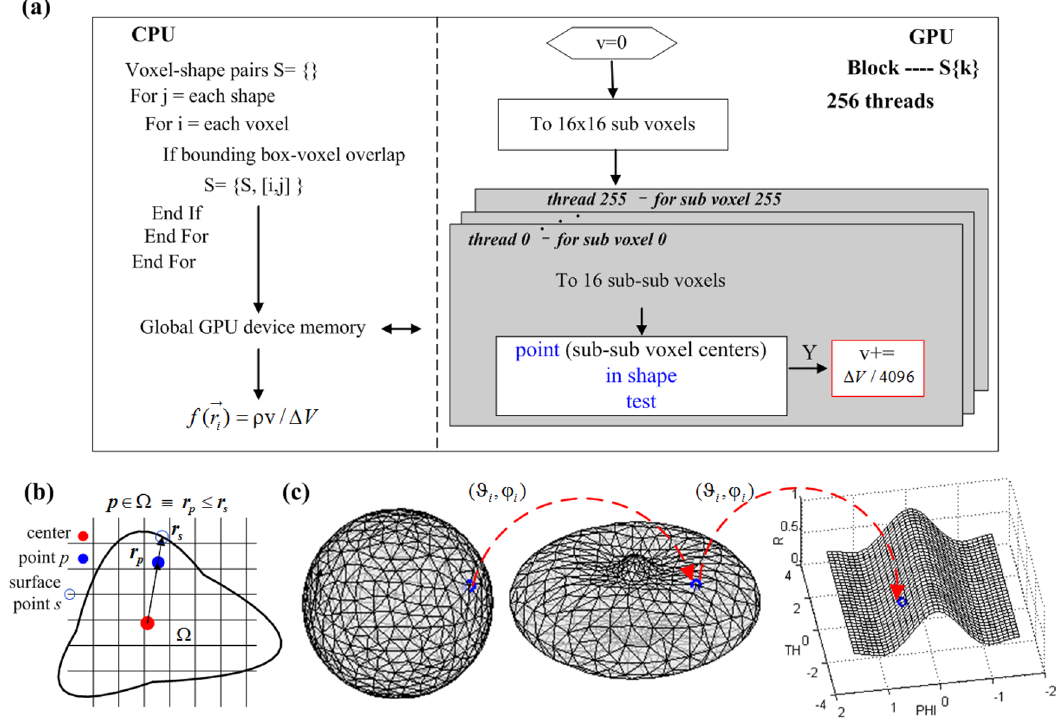
Figure 2. Shape-voxel mapping. (a) Flowchart of the GPU-accelerated computation of shape-voxel mapping. (b) Illustration of how to determine whether a point is inside a polar shape. (c) Digitalization of spherical harmonics parameterized shape with triangular mesh surface. The parameterized-shape surface mesh (middle) is generated by mapping a predefined triangular meshed unit sphere surface (left). For each mesh node (e.g., blue circle), its new radius on the parameterized-shape surface is found by keeping its ( q i , Q i ) unchanged. Further, a regular table is generated in the spherical coordinates ( q , Q ) space from these mesh nodes for faster point-in-shape determination.